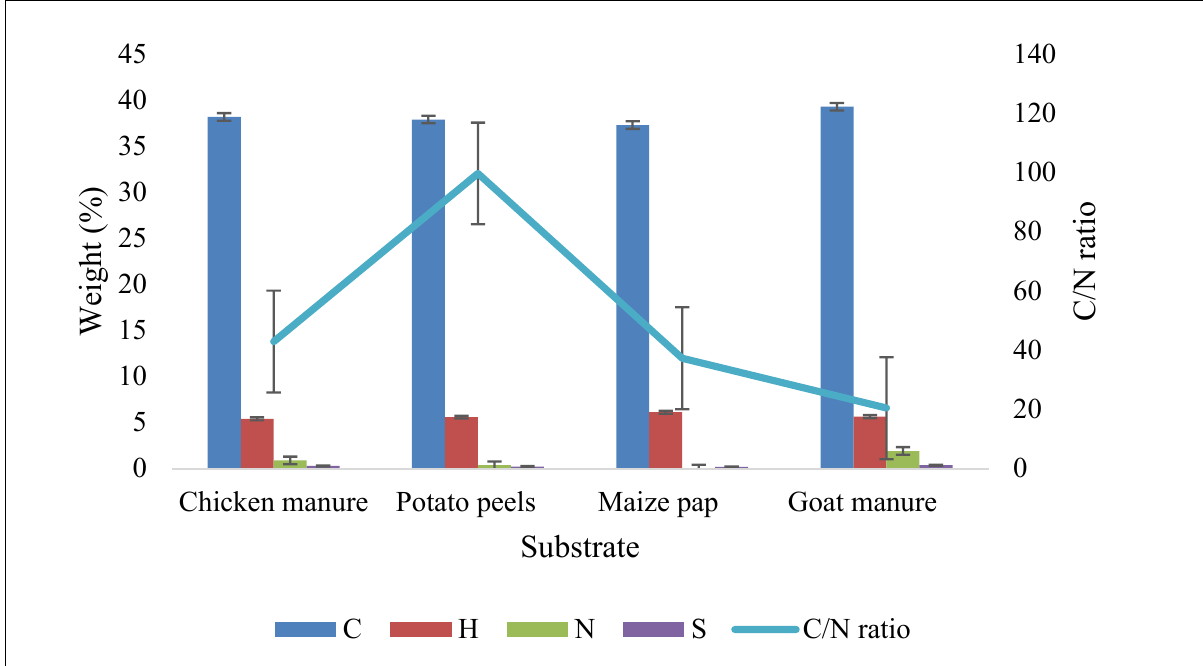
Figure 5: Results of the ultimate analysis of the